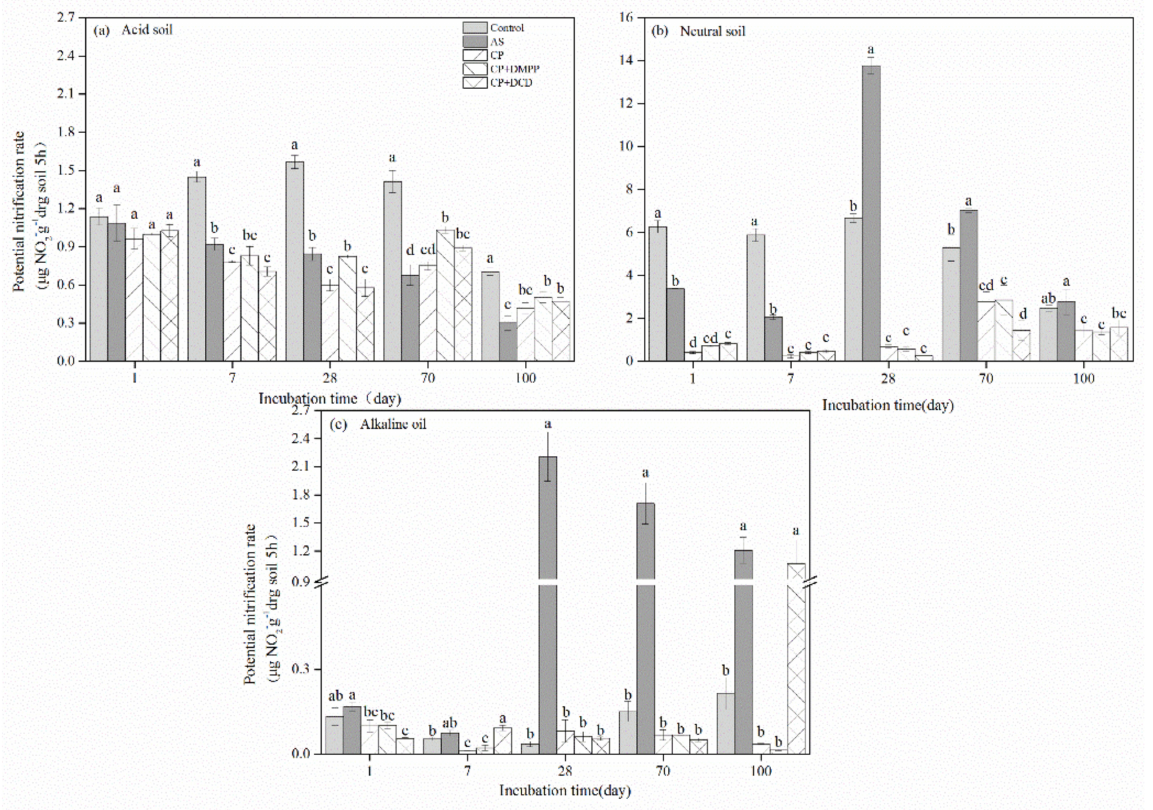
Figure 3. Potential nitrification rate (PNR) in the acid ( a ), neutral ( b ) and alkaline soils ( c ) under different treatments on each sampling day during the incubation. Error bars represent standard deviations (n = 3). The different letters above the figures of the same sampling day indicate significant differences between treatments at p < 0.05 by Tukey’s